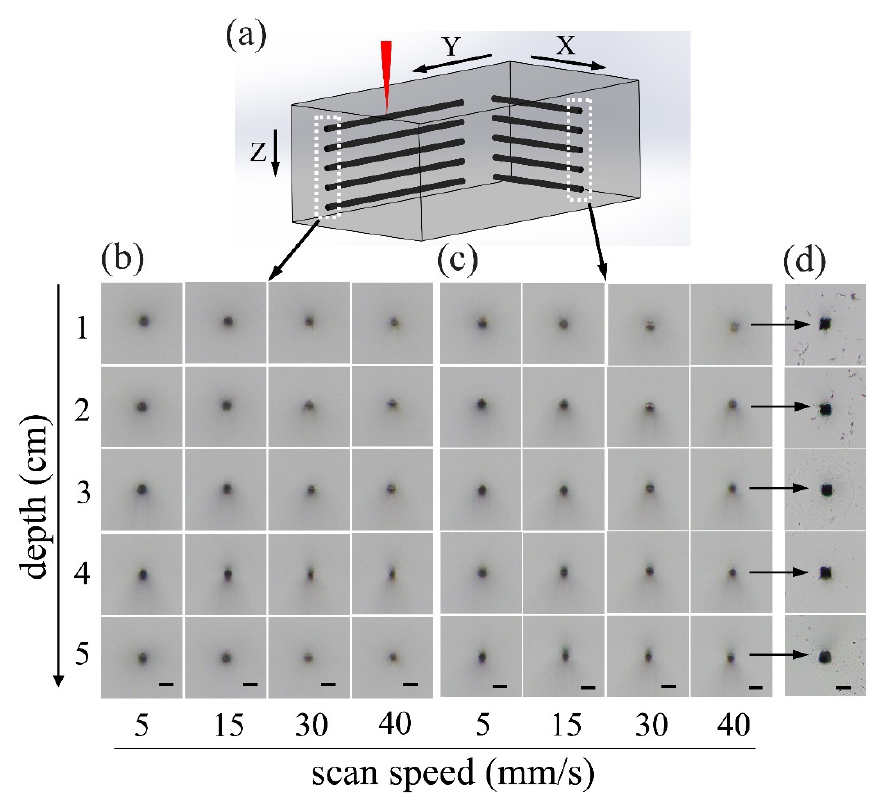
Figure 3. The fabrication feature size offered by loosely focusing the picosecond laser pulses into fused silica. ( a ) Schematic illustration of inscribing lines within a cube of fused silica along the X and Y direction. Cross-sectional optical micrographs of the lines written along the ( b ) Y and ( c ) X directions. ( d ) Cross-sectional micrographs of the hollow channels produced by chemically etching the inscribed sample in the last column of (c). Scale bar: 25 μ m.